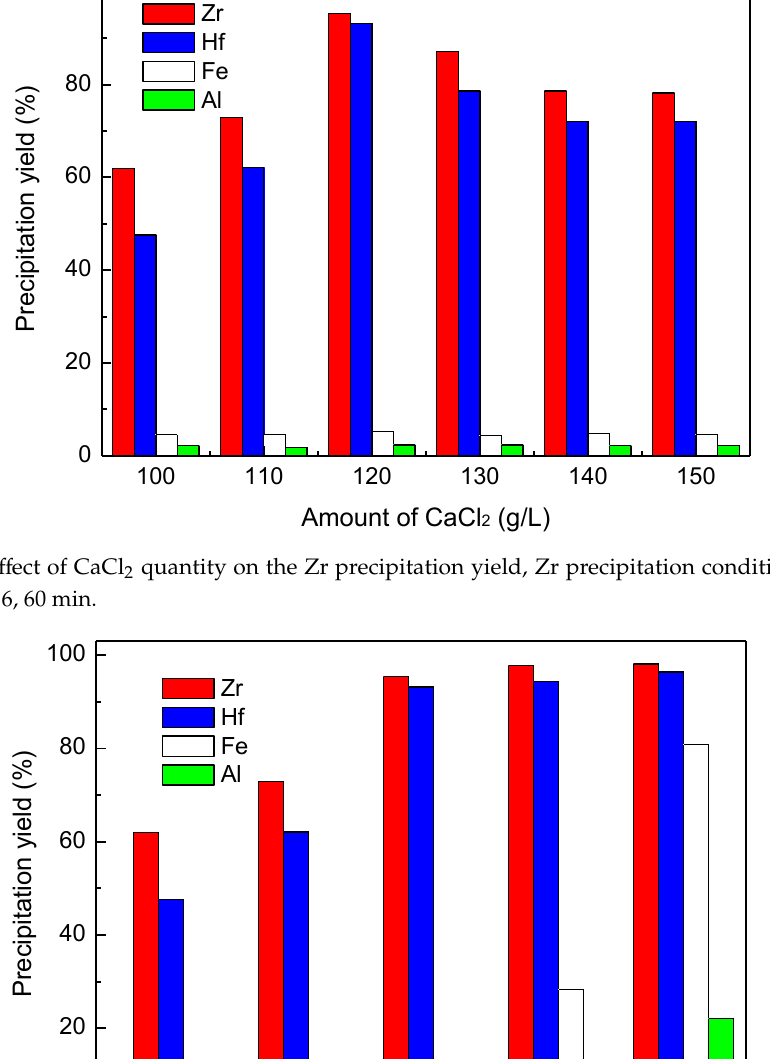
25 Figure 8. Effect of temperature on the Zr precipitation yield, Zr precipitation conditions: final pH ~1.6, C(SO 42‒ ) = 12.4 g/L, 60 min. 3.5 Effect of Time on the Basic Sulfate Precipiation The experimental results shown in Figure 9 indicate that the precipitation process was very fast. The precipitation yields of Zr and Hf reached 96.1% and 91.5% when the precipitation time was 60 min. No further increase in yield was noted with longer reaction time. Thus, 60 min was considered to be the optimum reaction time for the basic zirconium precipitation here. It may be considered to